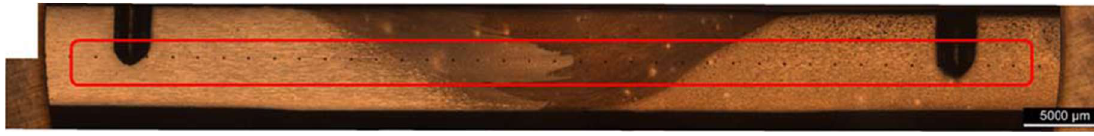
Figure 3. Microhardness measurement indentations across a FSW joint.